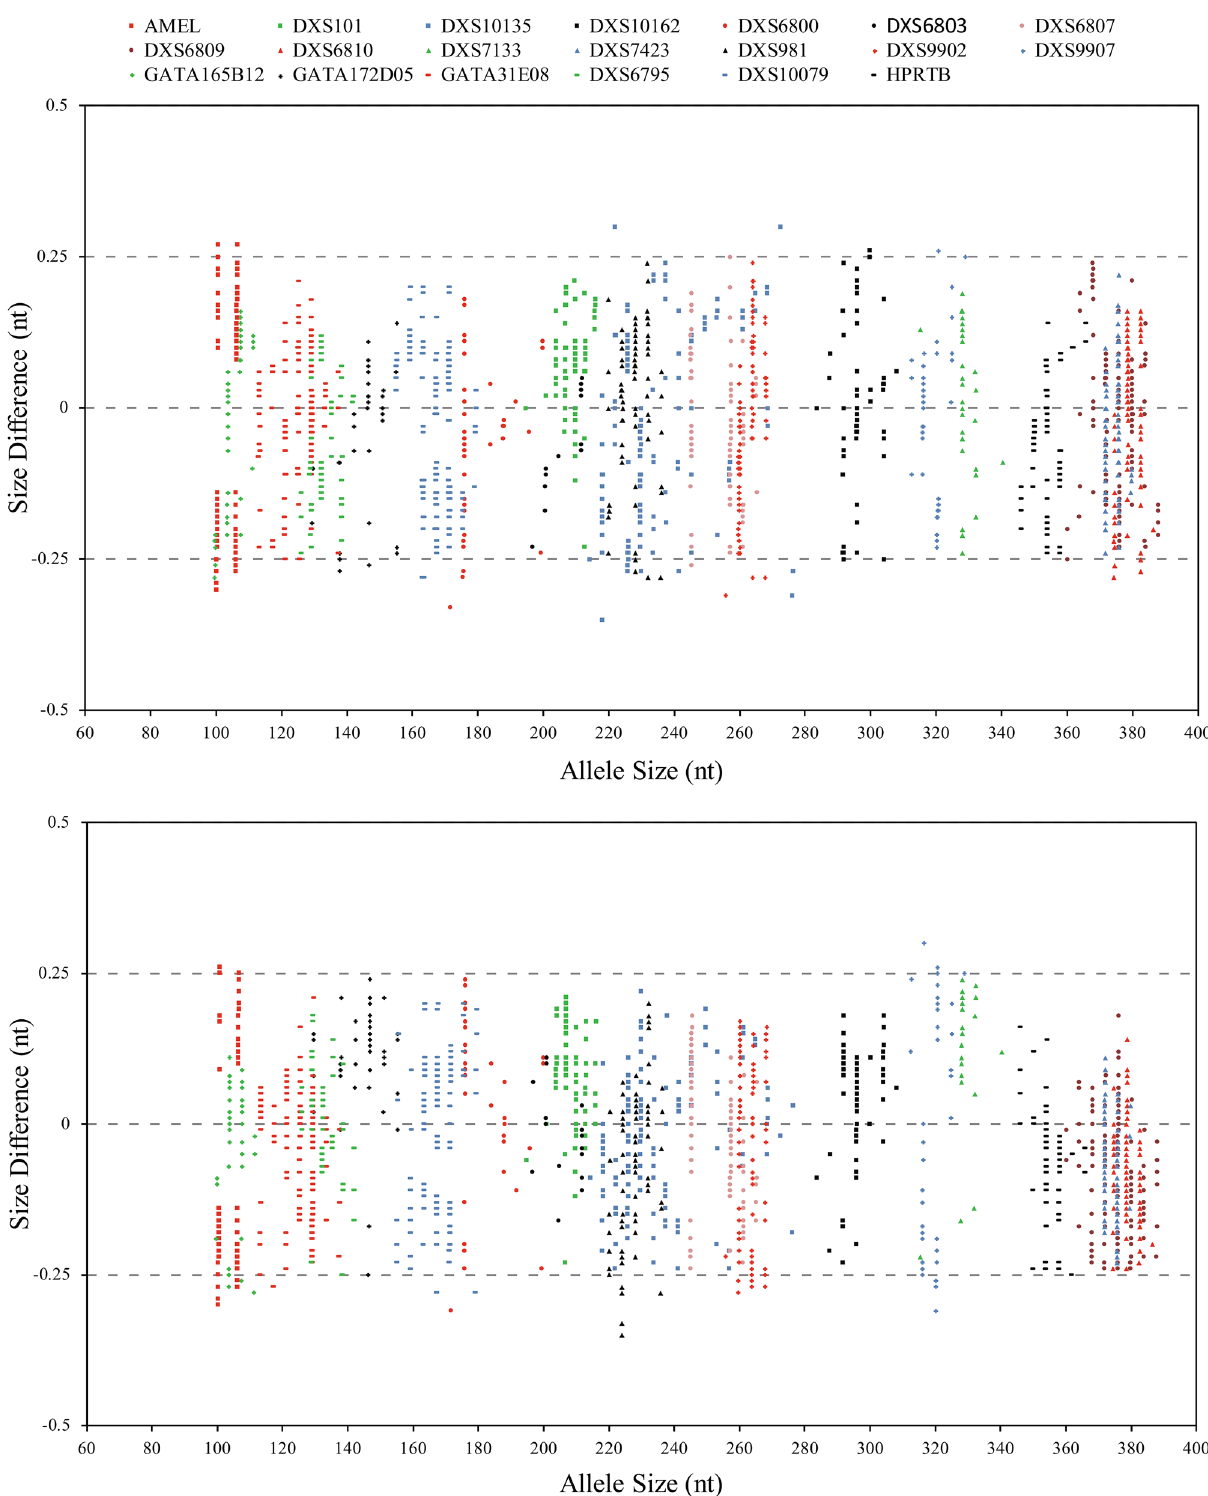
Figure 3. Accuracy of allelic ladders analyzed on a 3500xl Genetic Analyzer (n = 48, top) and on a 3130xl Genetic Analyzer (n = 32, bottom). The x-axis indicates allele size, while the y-axis represents difference from expected